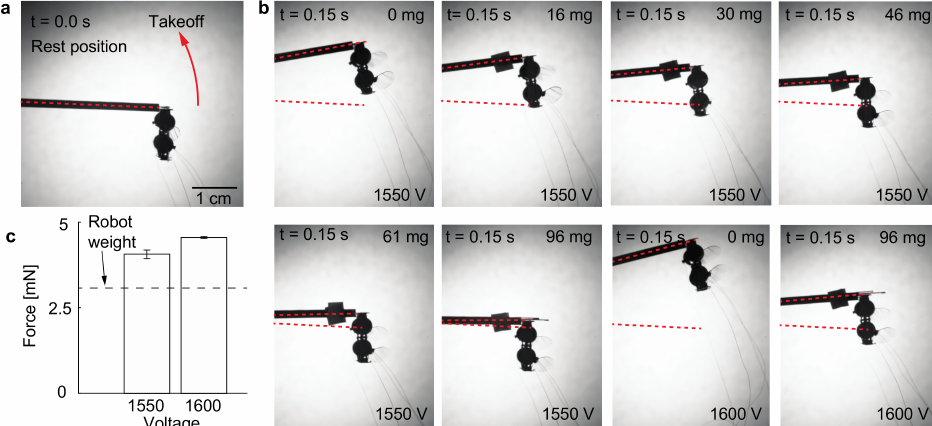
Figure 4. Calibration of mean lift force measurement. ( a ) The robot rest position at t = 0.0 s. ( b ) Positions of the robot at t = 0.15 s. The robot carries different payloads in these tests and it is either operated at 1550 V or 1600 V. ( c ) Measured mean lift forces at the two driving conditions. The error bars indicate the minimum and maximum